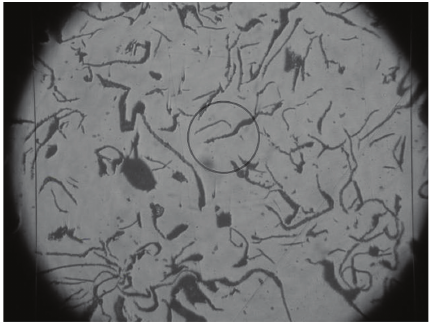
Figure 12: Microstructure in zone B